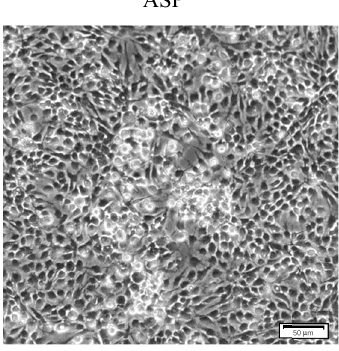
Figure 7. Glutamine increases the yield of ISKNV in CPB cells. The viral copy number was determined by fluorescent real-time PCR (TaqMan). ( A ) The yield of ISKNV in culture medium with 2 mM glutamine (Replete) or without glutamine (–Gln); ( B ) the yield of ISKNV in culture medium supplement with 2, 4, 6, and 8 mM glutamine at 7 days post-infection (dpi).